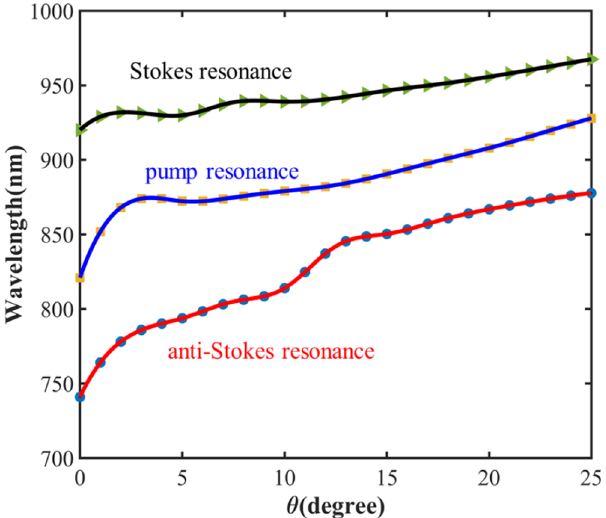
Fig. 7. Resonancewavelengthsdependenceontheincidenceangle for the three resonance peaks of the investigated metasurface.